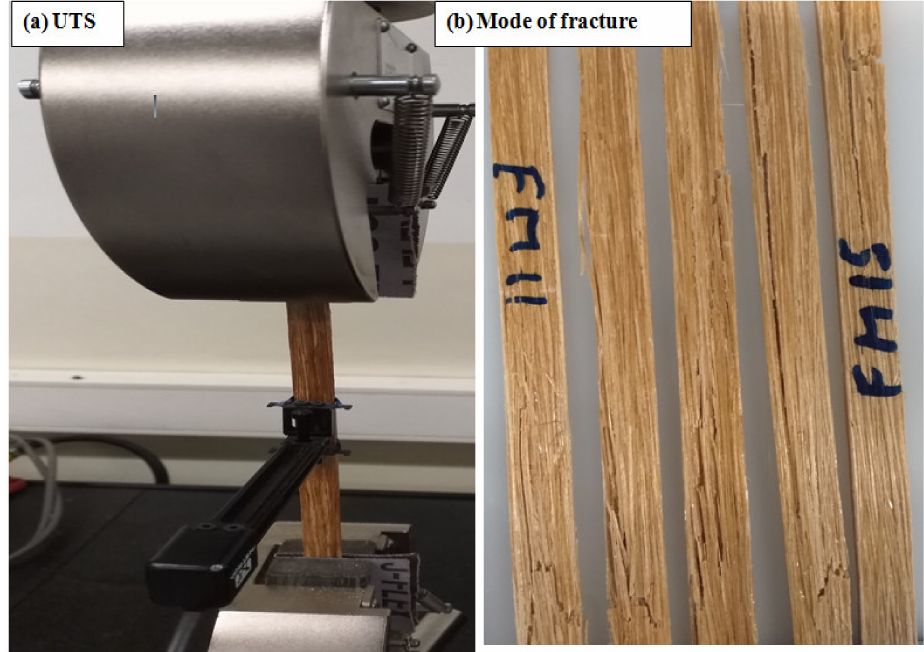
Figure 4. ( a ) Setup for the tensile test and ( b ) fracture after